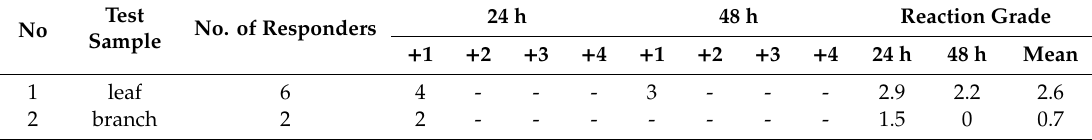
Table 6. Results of human skin primary irritation test (n = 34).